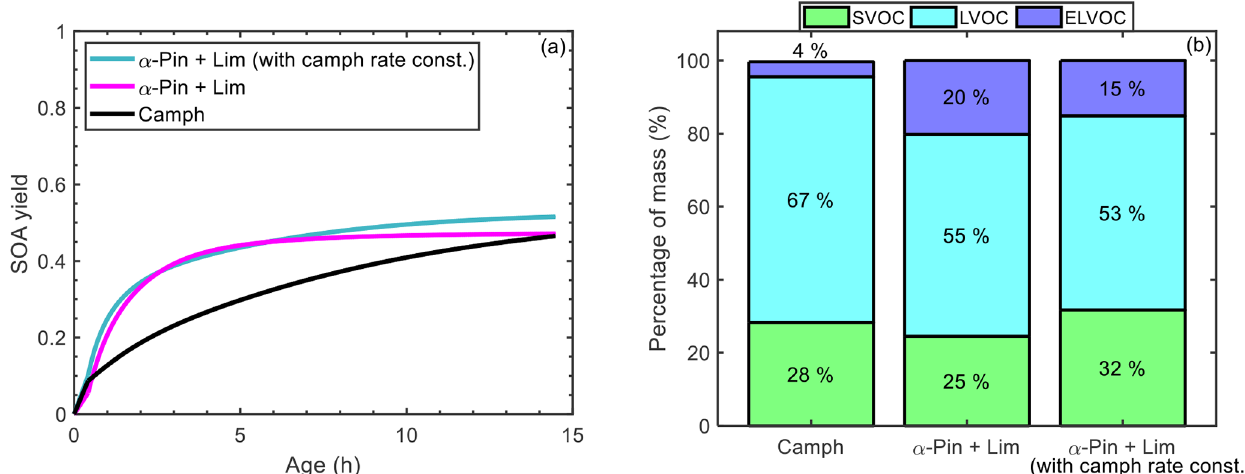
Figure 12. (a) Simulated SOA yield as a function of atmospheric aging time for camphene (black line), 50% α -pinene + 50% limonene (magenta line), and 50% α -pinene + 50% limonene in which the rate constants of α -pinene and limonene were replaced with the rate constants of camphene (green line); and (b) mass percentage of four volatility categories in the particle phase at the end of the controlled reactivity simulations for camphene, 50% α -pinene + 50% limonene, and 50% α -pinene + 50% limonene in which the rate constants of α -pinene and limonene were replaced with the rate constants of camphene. Table 4. SOA yield and mass predicted using two-product and VBS parameters for the top five monoterpenes by emission factor (EF) from black spruce, Douglas fir, and lodgepole pine. For each fire fuel, the monoterpenes were represented using two different surrogate assignments. In Assignment 1, α -pinene is used to represent all monoterpenes except limonene. In Assignment 2, camphene is represented as 50% α -pinene + 50% limonene. There is no Assignment 2 for lodgepole pine because camphene is not one of the top five monoterpenes by EF. The percentage (%) increase in SOA was calculated based on the difference between the total SOA of assignments 1 and 2. The EFs of assignments 1 and 2, the two-product SOA parameters, and the VBS parameters are provided in Tables S2–S4, respectively. Yield α pin Yield lim SOA α pin SOA lim SOA total % increase (µgm − 3 ) (µgm − 3 ) (µgm − 3 ) in